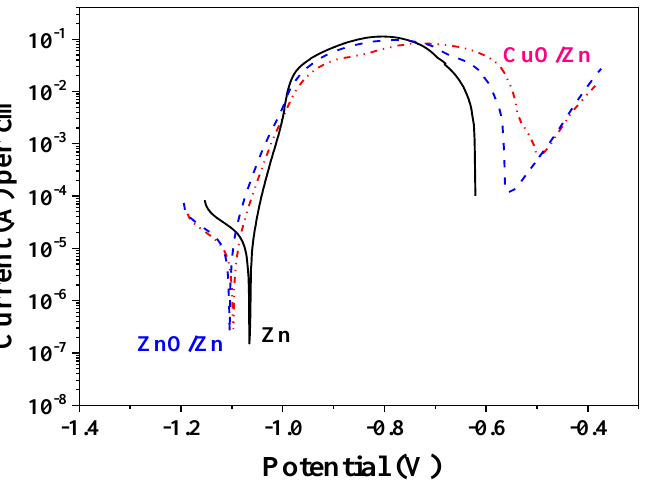
Figure 6. Potentiodynamic polarization measurements of ordinary Zn and both hybrid coatings in the model corrosive medium of 5% NaCl.